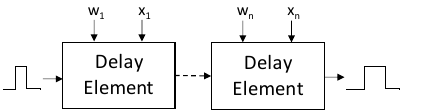
Figure 1. Illustration of time-domain model [28].